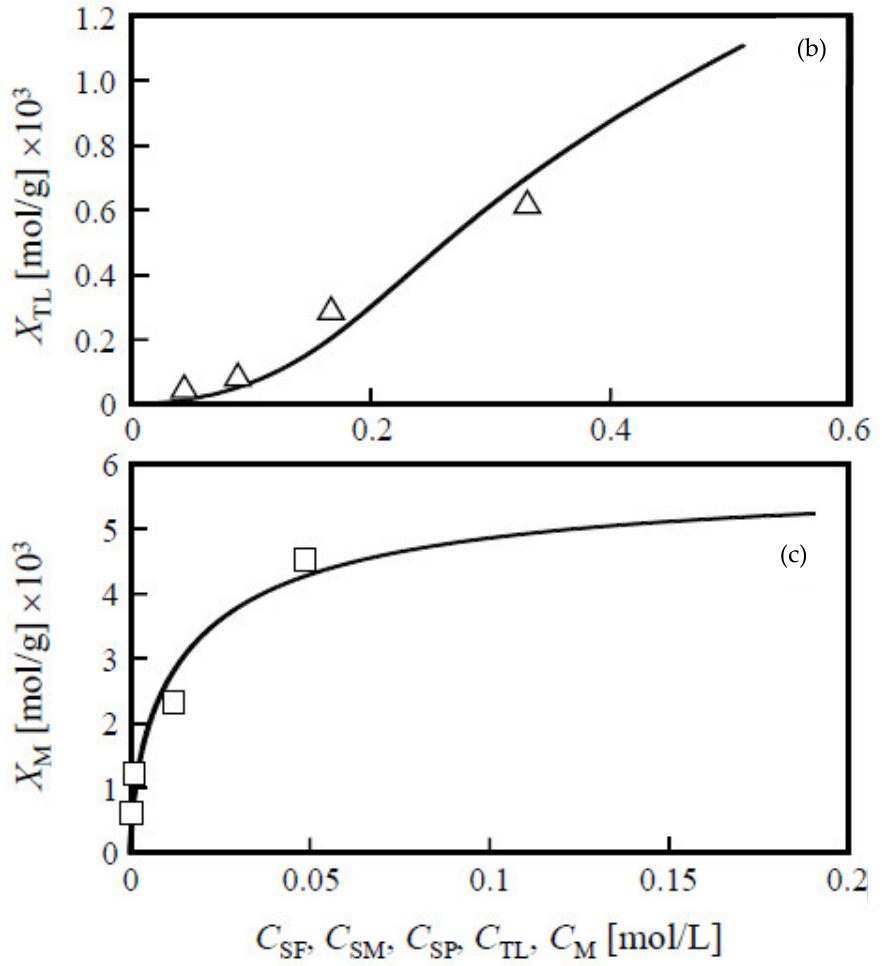
Figure 2. The adsorption isotherms: ( a ) SF, MF, and PF; ( b ) TL; ( c ) ME. The solid lines are values calculated using Equations (5)–(9) and the parameters in Table 5.